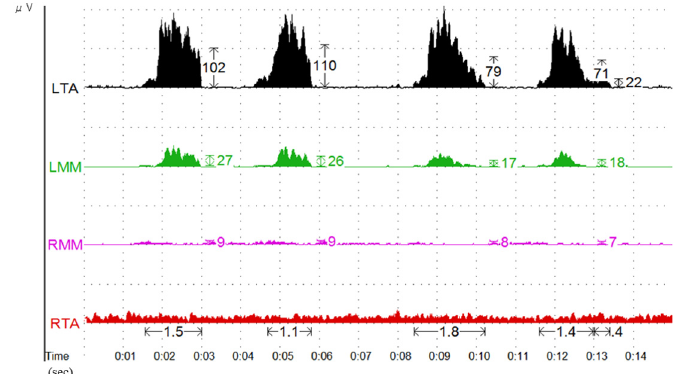
Figure 4. Surface electromyography: Action potential was not recorded from the right masseter and temporal muscles. Left anterior temporalis (LTA), left masseter (LMM), right masseter (RMM), right anterior temporalis (RTA). X -axis: time, Y -axis: EMG activity ( μ V).